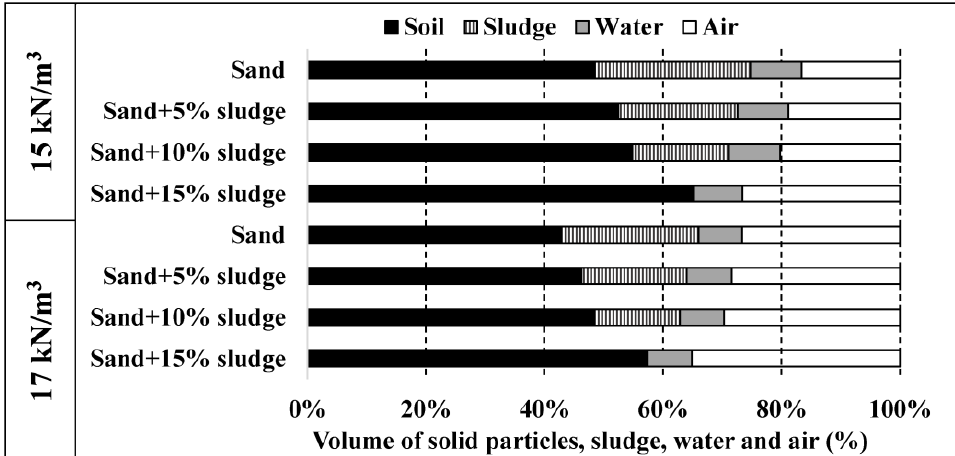
Figure 11. Volume, in %, of the different mixture components.